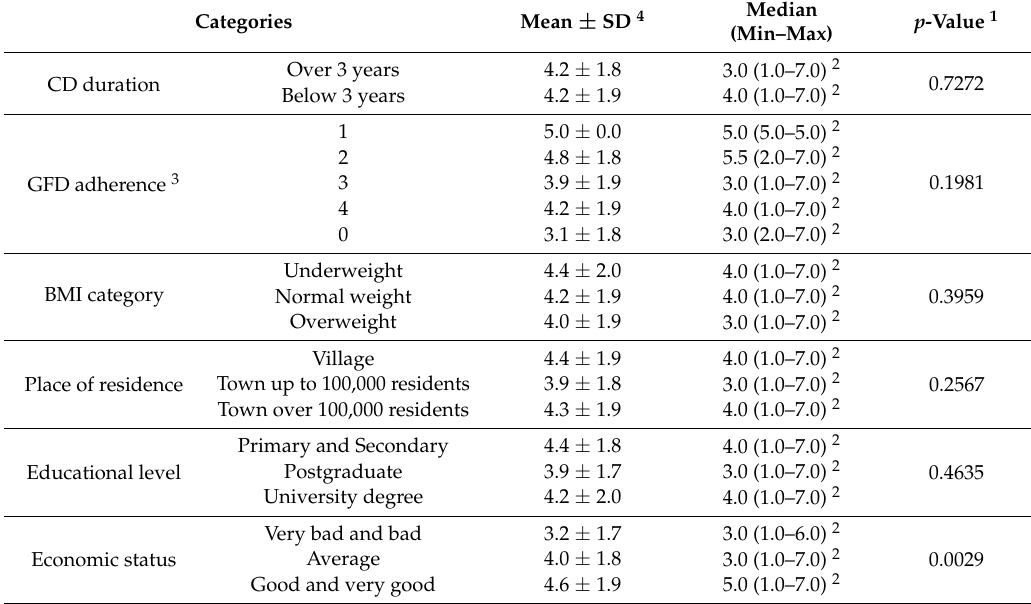
Table 6. Purchase-related emotions and behaviors data regarding question about mood affecting purchase decisions ( In the past 2 weeks, how many times did your mood affect your purchase decisions associated with GF products? ) categorized by CD duration, GFD adherence, BMI and sociodemographic characteristics.